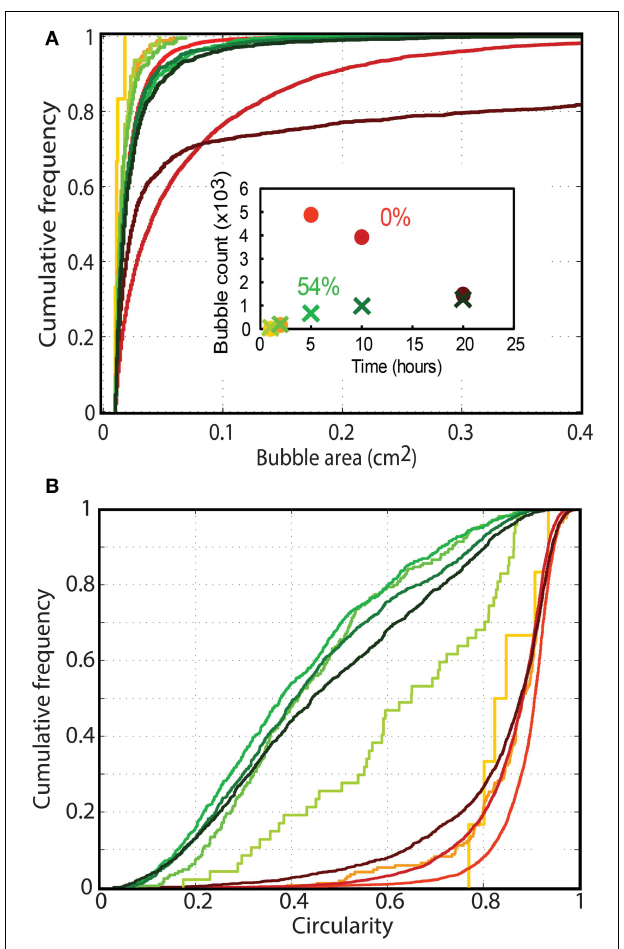
FIGURE 8 | Cumulative frequency distribution of (A) bubble circularity and (B) bubble sizes in particle rich (green; 54 vol% or φ = 1 ) and particle free (orange; φ = 0 ) foam generation experiments. The color gradient shows the migration of distributions with time at t = 1 , 2, 5, 10, and 20h (as shown in the inset graph). Only bubbles larger than 0.01cm 2 are considered, and the first lines in each series appear jagged because they are built from measurements on few bubbles. The number of bubbles considered in each measurement is shown in the inset graph (colors are consistent with Figures 7A,B ). The profiles clearly differ for particle-rich (small, highly deformed bubbles) and particle-free experiments (rounder bubbles that continually grow with time).